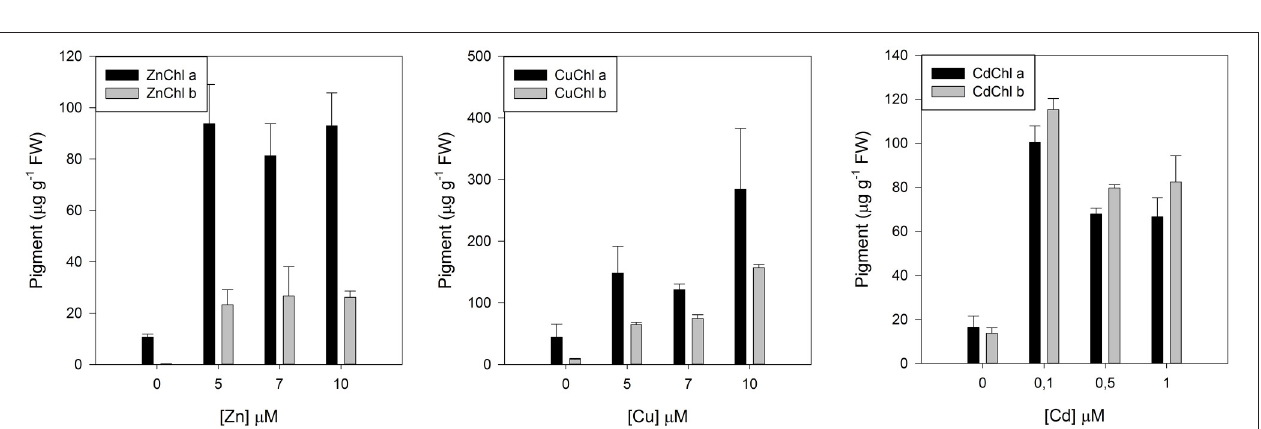
FIGURE 7 | Heavy metal substituted chlorophylls in Juncus accutus plants exposed to increasing concentrations of zinc (Zn), copper (Cu), and cadmium (Cd). Data is presented as average ± standard deviation. The concept of this figure is based on Santos et al. (2014,